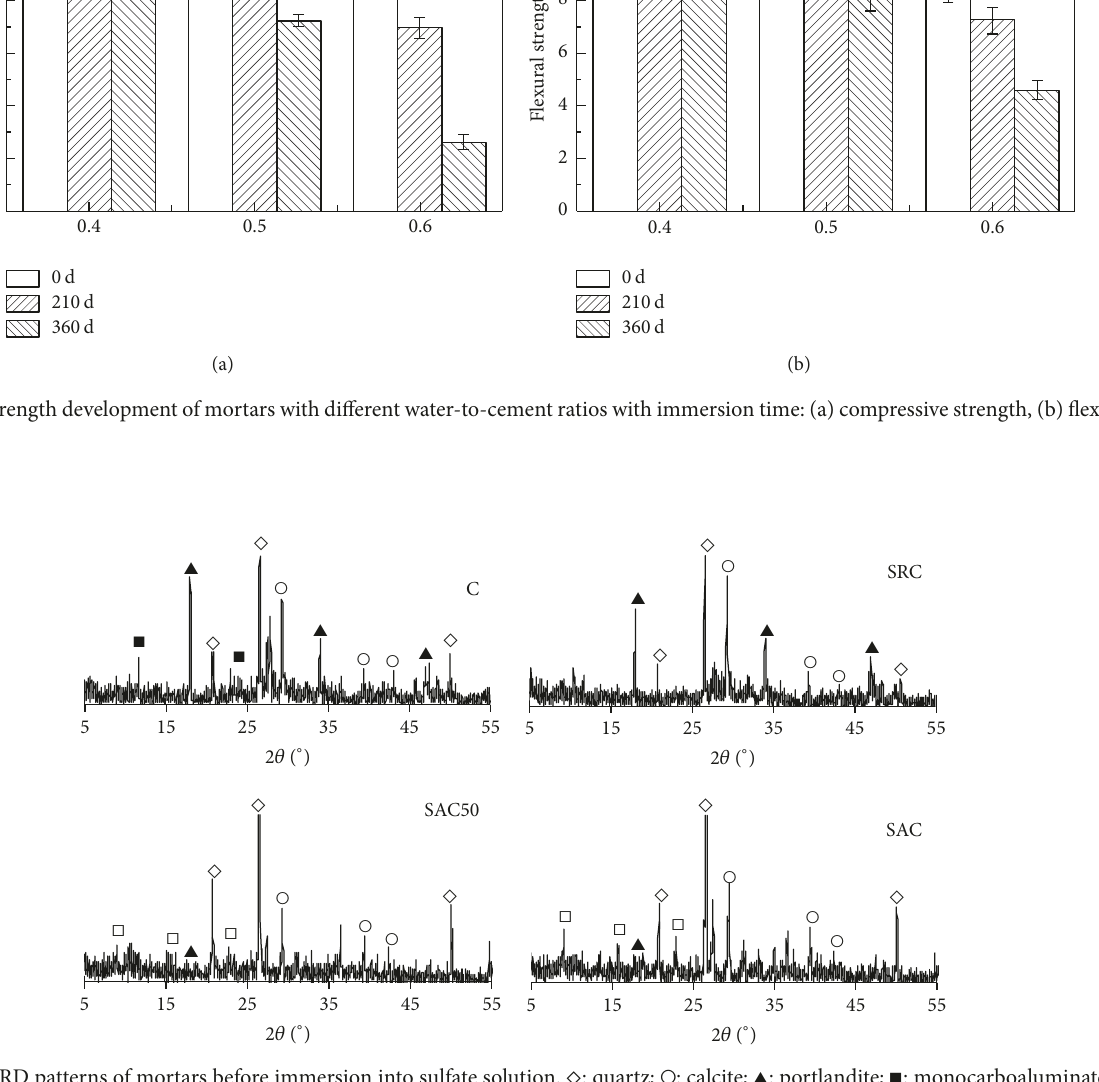
Figure 4: XRD patterns of mortars before immersion into sulfate solution. ⬦ : quartz; I : calcite; 󳵳 : portlandite; ◼ : monocarboaluminate; ◻ :